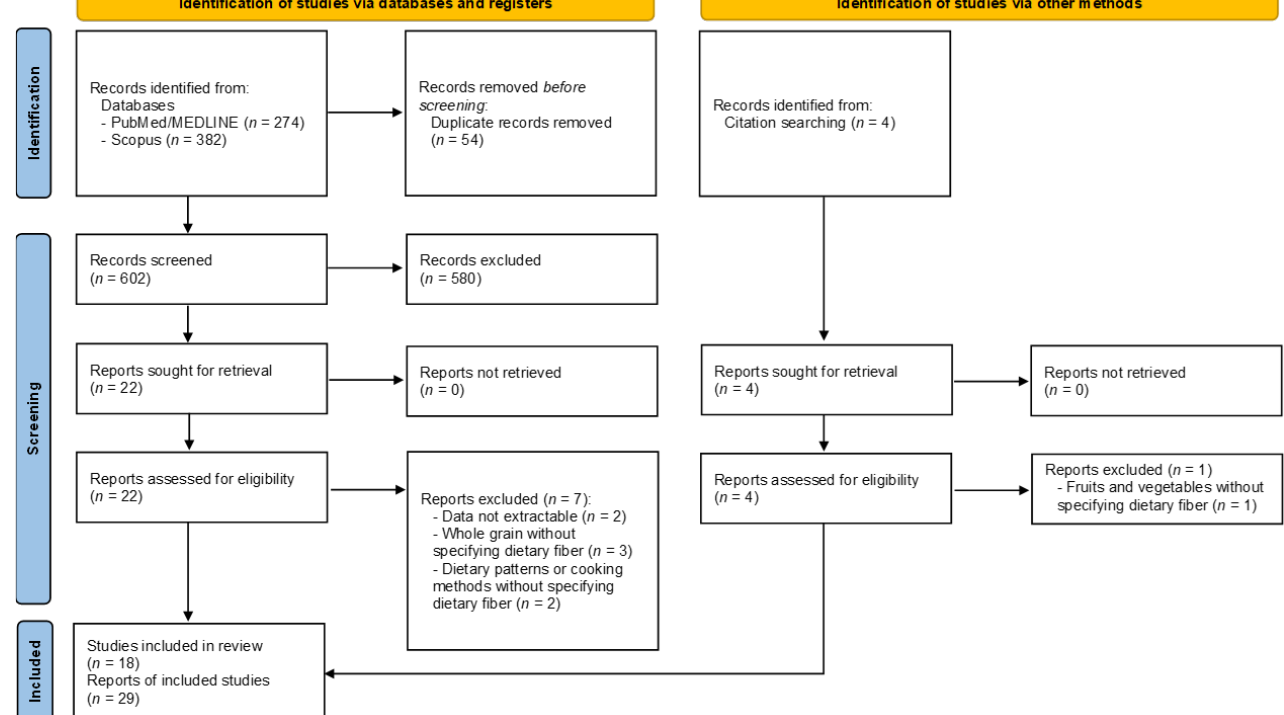
Figure 1. Flowchart of the study selection process.